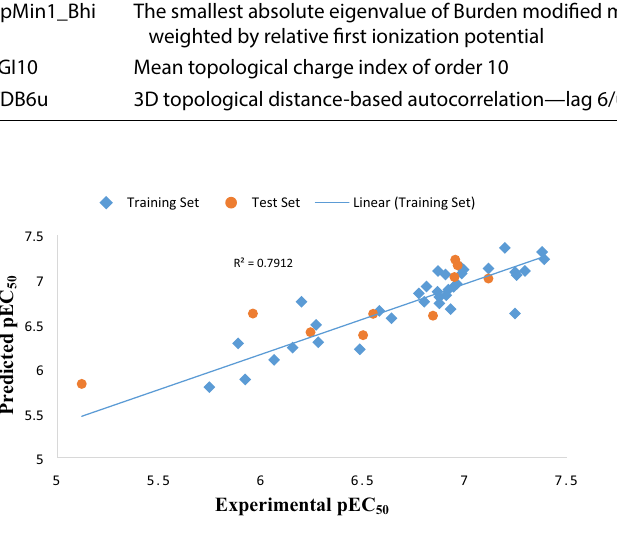
Fig. 1 The predicted against the experimental pEC training as well as the test sets